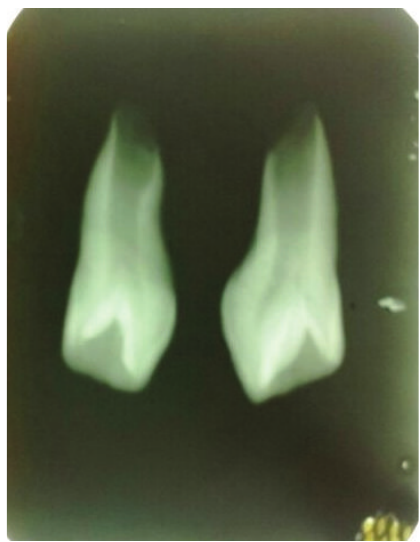
Figure 6: Postoperative X-ray showing incomplete root formation of